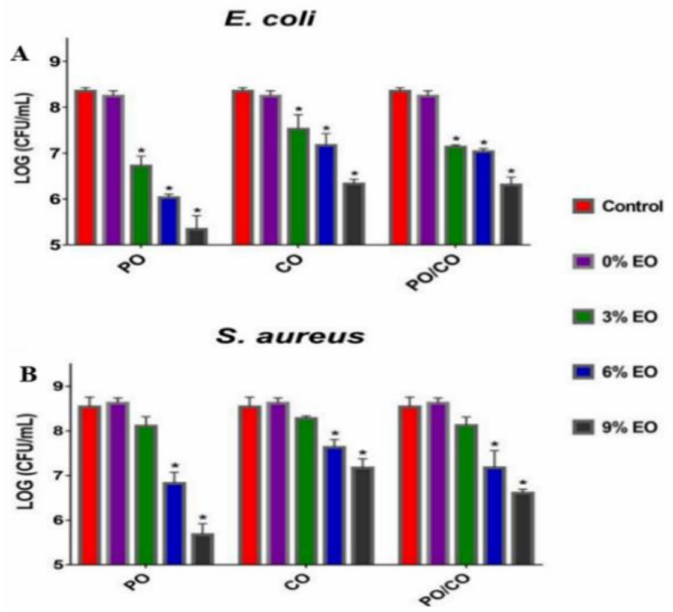
Figure 14. Bactericidal efficiency of Gel/essential oil nanofibers against ( A ) Escherichia coli and ( B ) Staphylococcus aureus . * p < 0.05 against the control group. Results are the mean ± SD ( n = 3). Reproduced from [262] with copyright permission from the American Chemical Society.